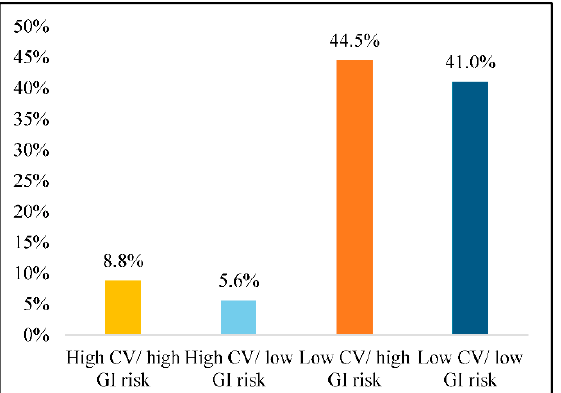
Figure 1. Percentage of Older Adults with Osteoarthritis and Potentially Inappropriate NSAIDs Use by Risk Categories. Note: Based on 44,990 older adults (age > 65) with OA using data from Optum